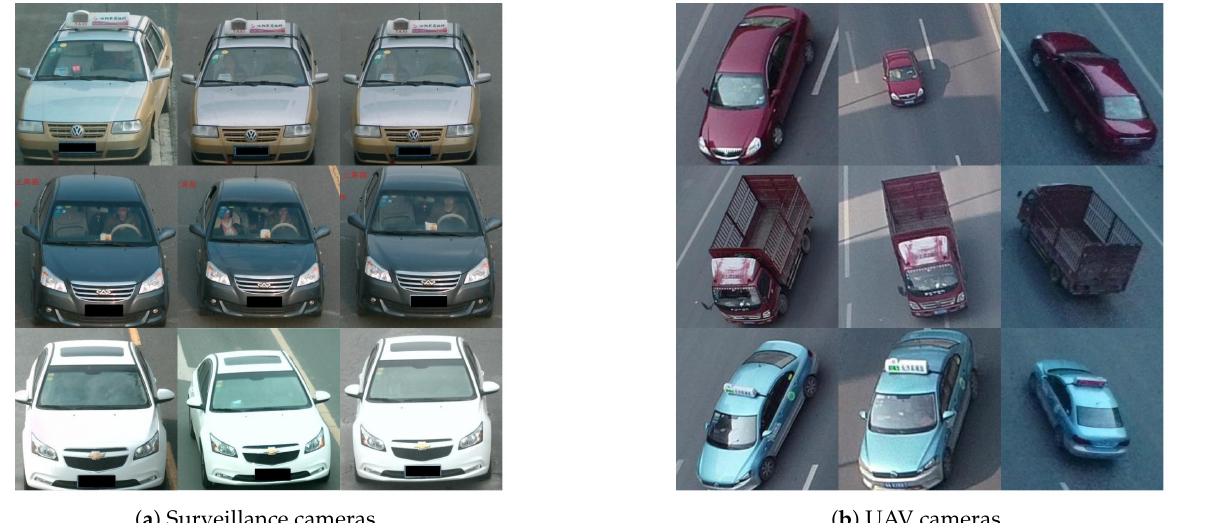
Figure 1. The comparison of vehicle images by surveillance cameras and